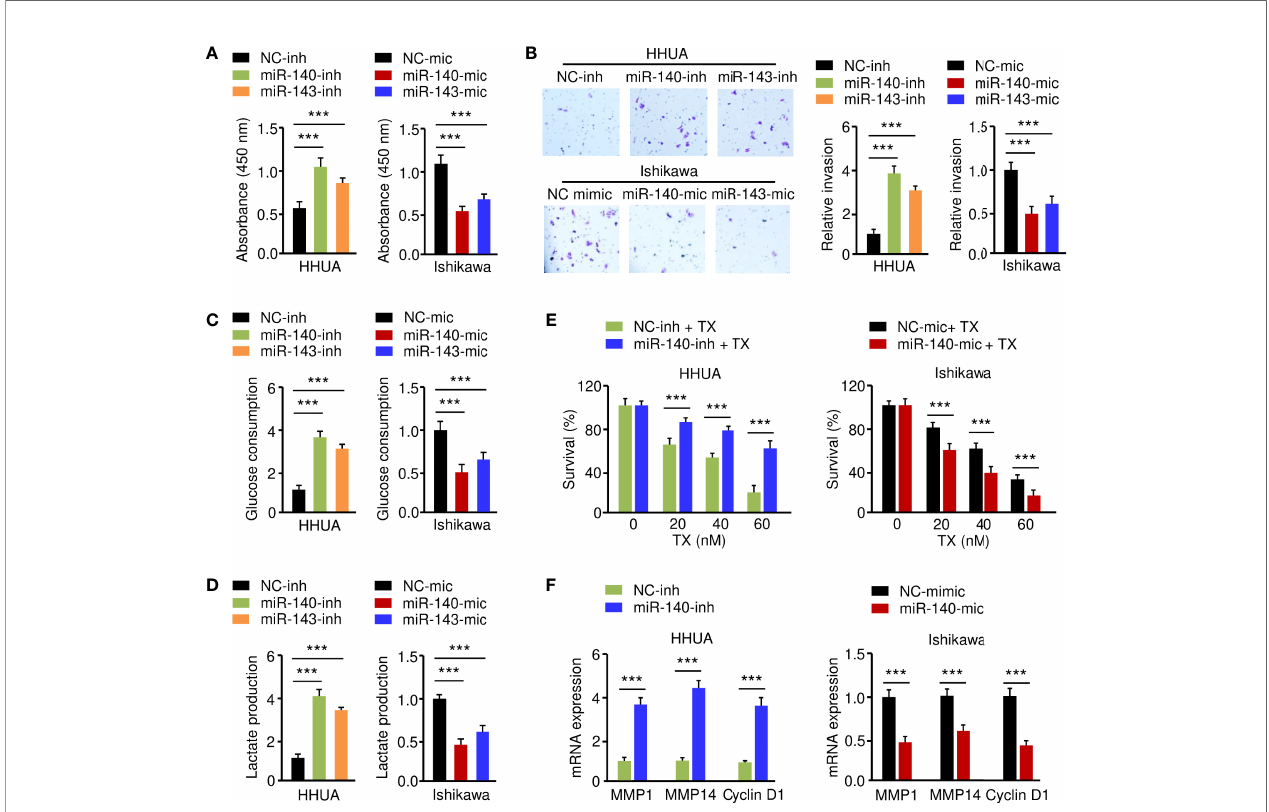
FIGURE 6 | MiR-140 and miR-143 Suppress Glycolysis and Chemoresistance of EC Cells. (A – D) Proliferation (A) , invasion (B) , glucose consumption (C) , and lactate production (D) assays in EC cells after miR-140 or miR-143 overexpression or knockdown. (E) HHUA cells transfected with miR-140 inhibitor (inh) and Ishikawa cells transfected with miR-140 mimic (mic) were treated with different concentrations of paclitaxel, and cell viability was examined using the CCK-8 assay. (F) The mRNA expression of the indicated genes was examined in Ishikawa cells after overexpression of miR-140, and in HHUA cells after the knockdown of miR- 140. *** P <